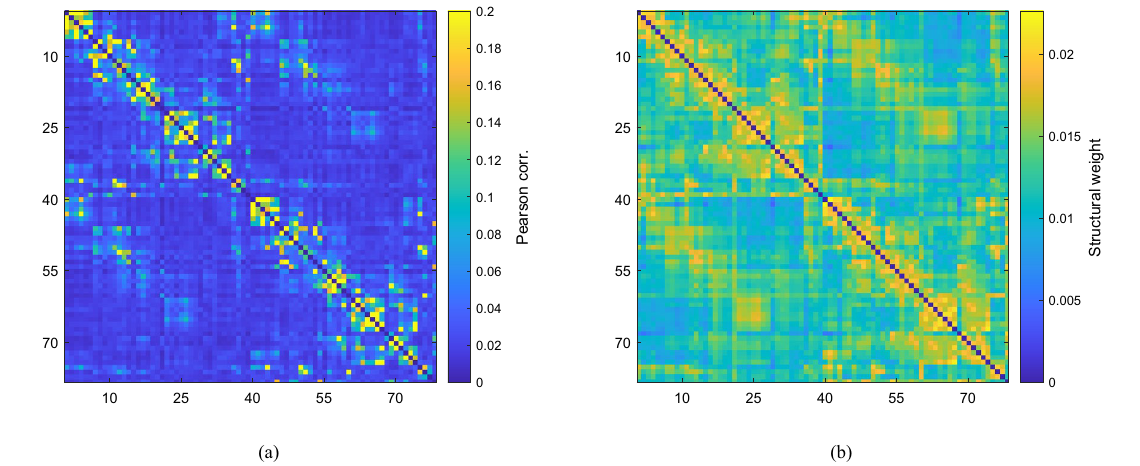
Figure 4. For ( P , Q ) values close to criticality the simulated functional connectivity ( a ) is found to resemble the empirical structural connectivity ( b ). The displayed functional connectivity network was obtained by averaging 100 simulations for specific parameter values ( P , Q ) = ( − 3.10, − 5.12 ) , which are highlighted by a circle in Fig. 3a; the corresponding Jaccard index is 0.195, and across realisations we observe maximal deviation in this value of ∼ 13%